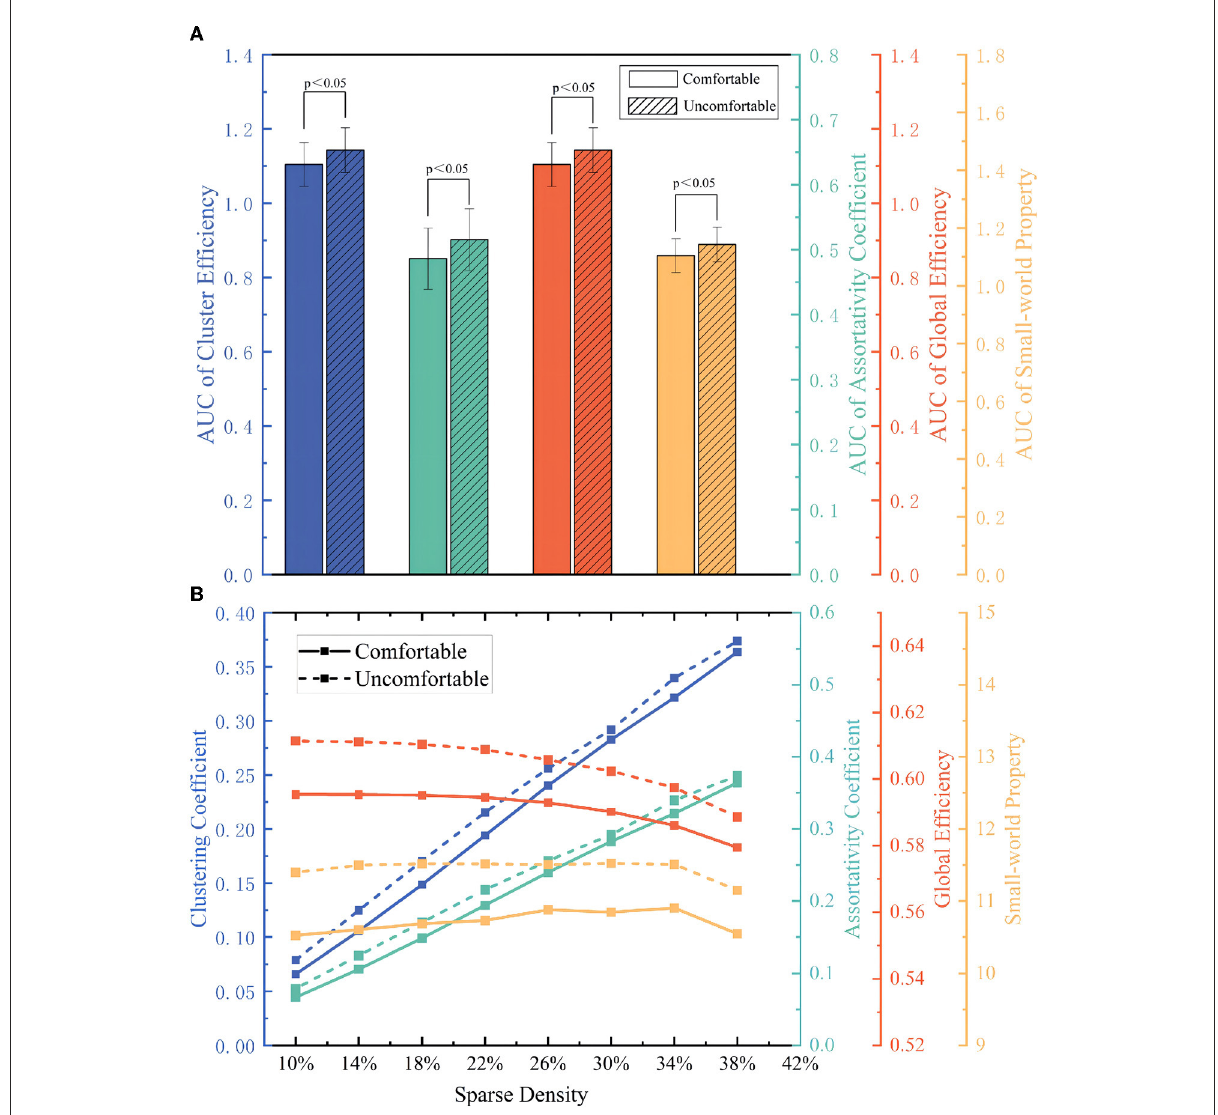
FIGURE4 (A) Global attributes index at different sparse density; (B) The AUC of global attributes index.